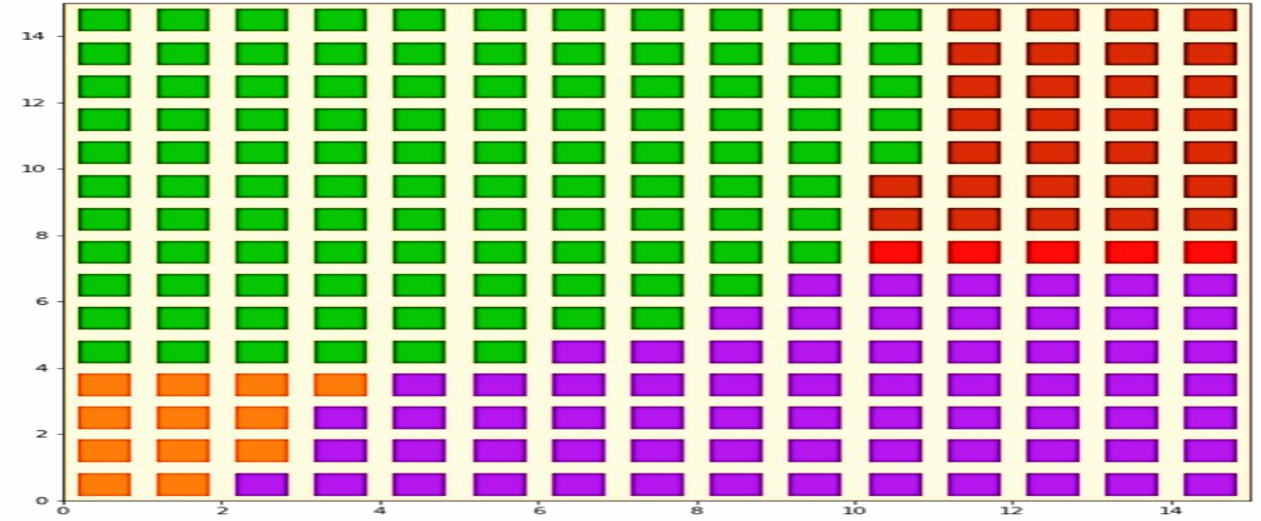
Figure 19. Clustering based on emotions through the self-organizing